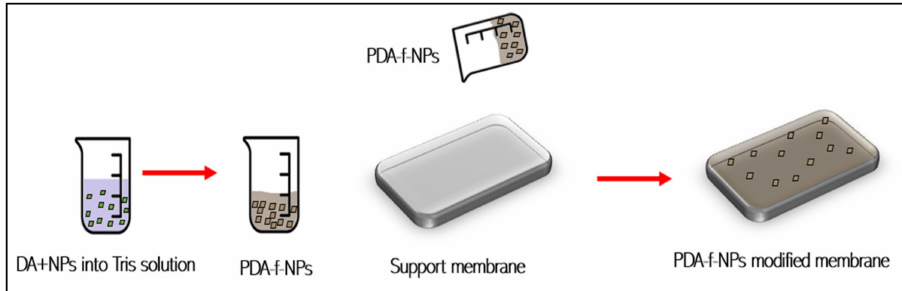
Figure 4. Simple deposition modification method using